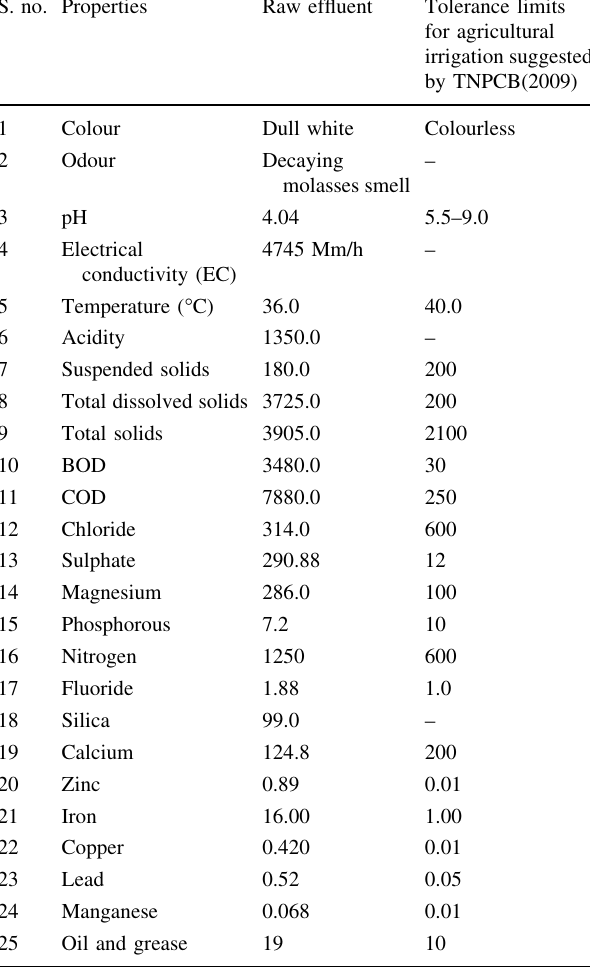
Table 1 Physico—chemical properties of sugar mill effluent S. no.